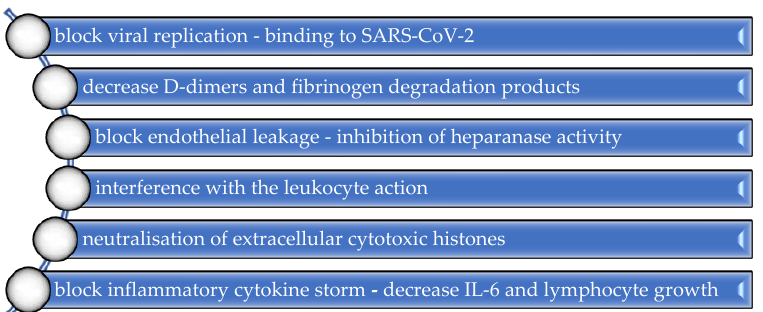
Figure 2. Non-anticoagulant properties of LMWH.